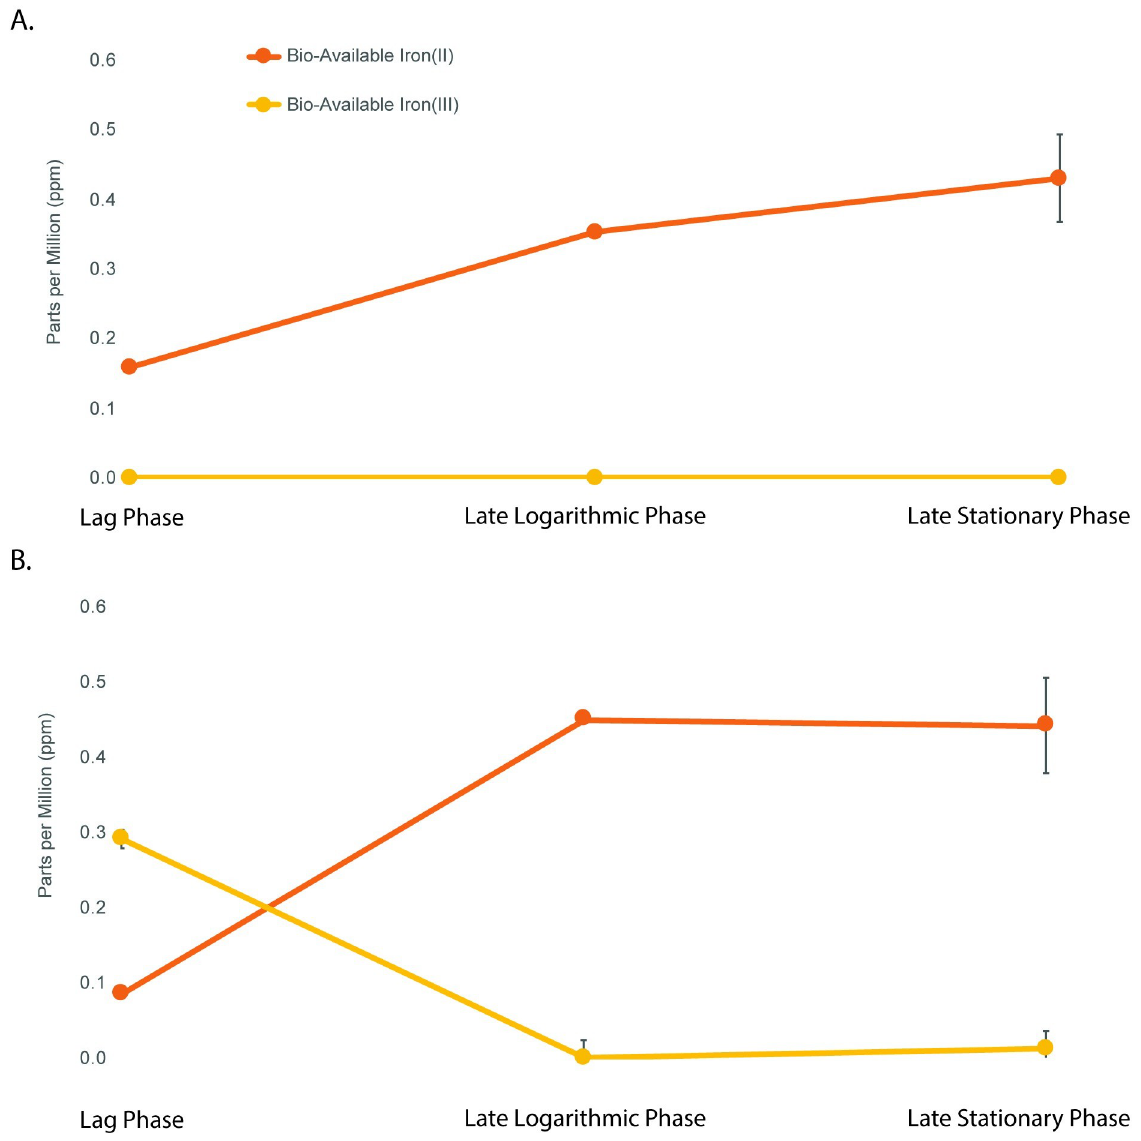
Fig 5. Bio-available Fe(II) (orange) and Fe(III) (yellow) concentrations in parts per million (ppm). Mean concentrations of Fe(II/III) ( ± SD) when BRL6-1 was cultured in (A) lignin-amended and (B) in unamended conditions at lag phase, late exponential phase, and late stationary phase (n = 3 for each